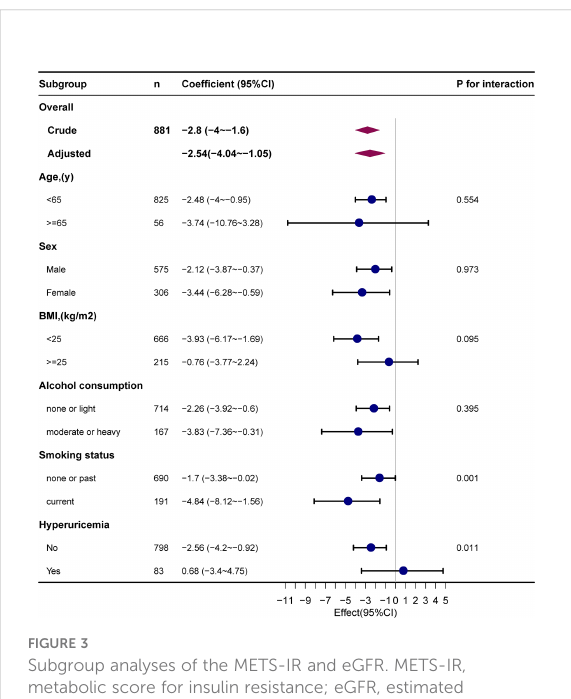
FIGURE 3 Subgroup analyses of the METS-IR and eGFR. METS-IR, metabolic score for insulin resistance; eGFR, estimated glomerular fi ltration